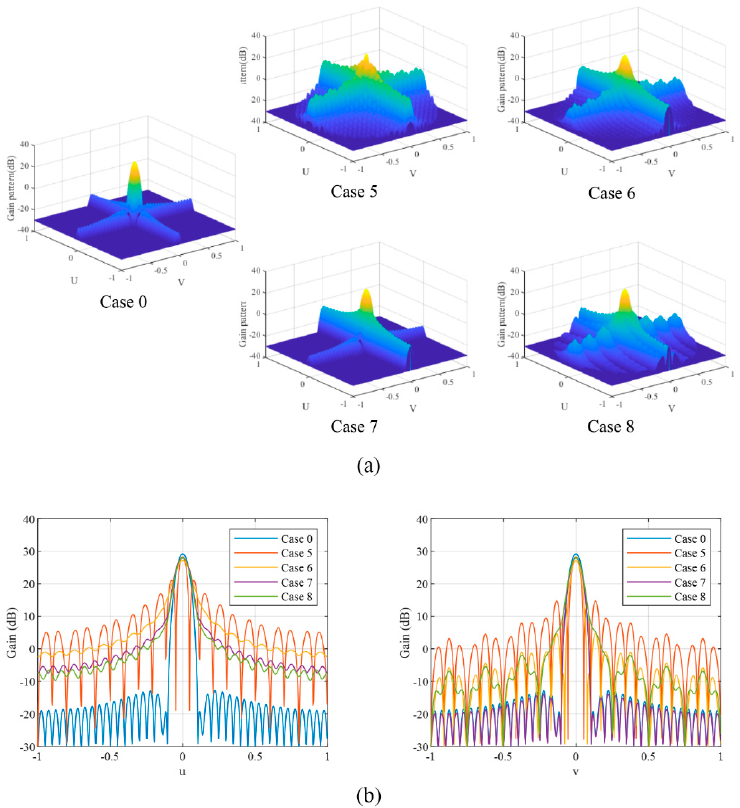
Figure 10. 3D ( a ) and 2D patterns ( b ) of the phased-array antenna in receiving mode in different failure elements distribution conditions.